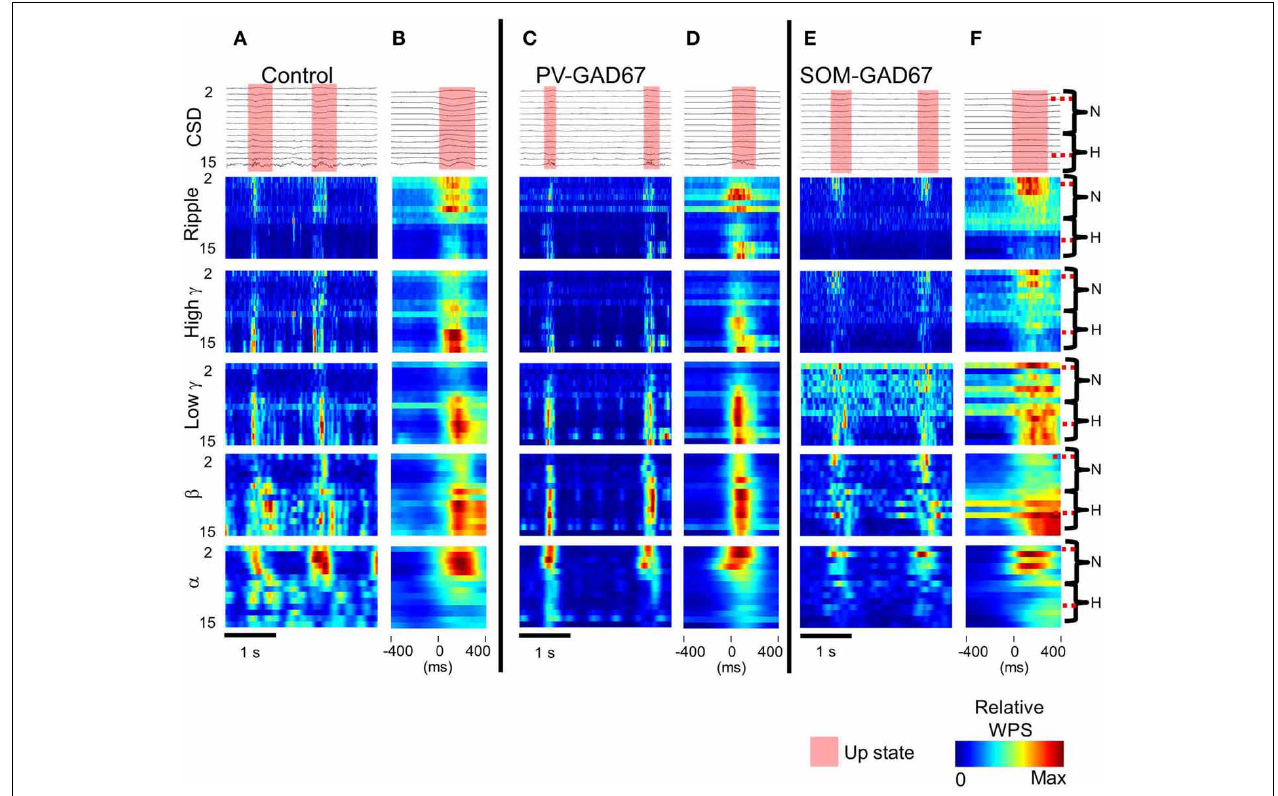
FIGURE 5 | The CSD WPS depth profiles in each high frequency band. (A) CSDs (top) and WPS example calculated from the CSDs sorted according to each high frequency band (from the bottom alpha, 7–14Hz; beta, 15–30Hz; low gamma, 30–60Hz; high gamma, 60–90Hz; ripple, 100–200Hz) in control mice. (B) Up state start-triggered average of CSDs (upper) and of WPSs